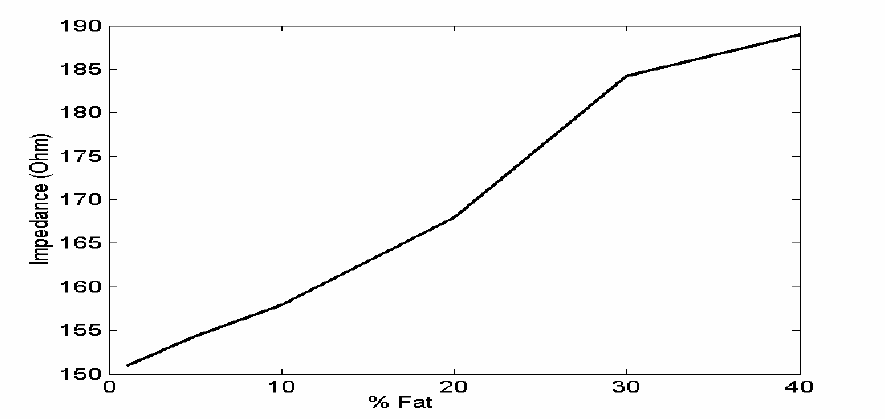
Figure 33. Variation of impedance with percentage of fat content at 750 MHz with 5 mm